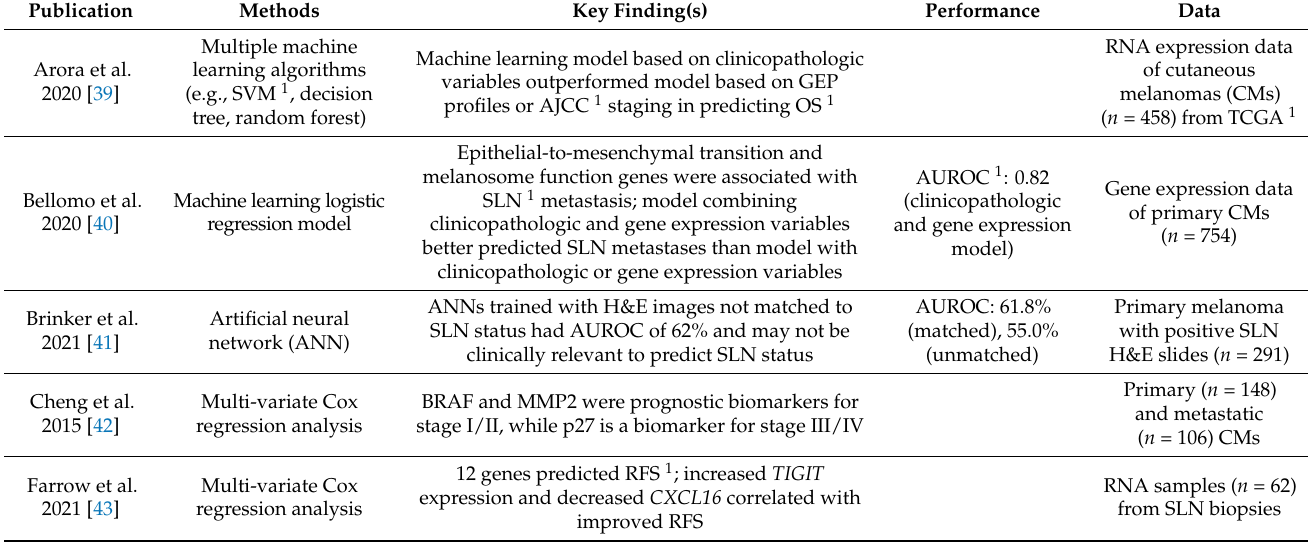
Table 1. Summary of major studies in bioinformatic and machine learning risk stratification of